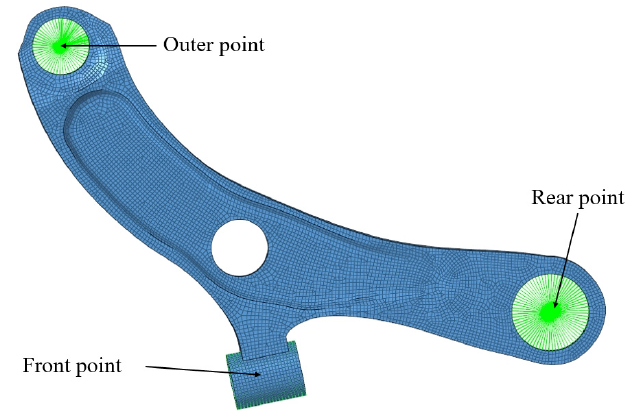
Figure 4. Finite element model of suspension control arm.